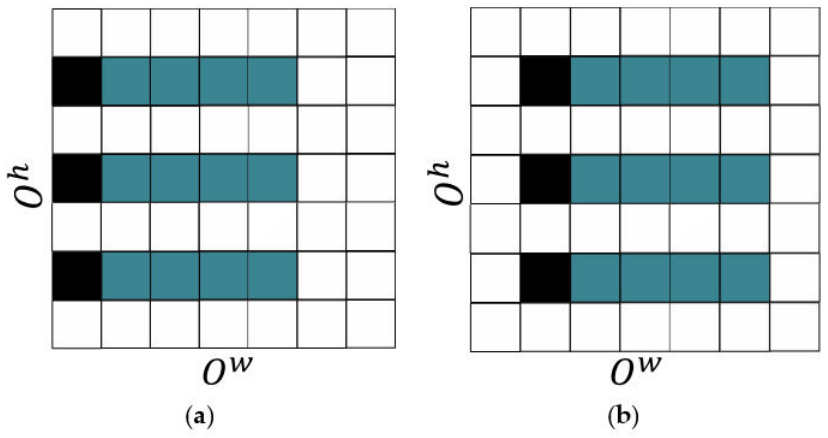
Figure 4. The illustration of the process described in Equation (4) using ξ h = 2 and processing two consecutive patches of O . Squares coloured with cyan signify the elements participating at the processing of O o h l , o w l , and coloured with grey are the elements of O o h l , o w l + 1 . ( a ) Processing of O o h l , o w l ; ( b ) Processing of O o h l , o w l + 1